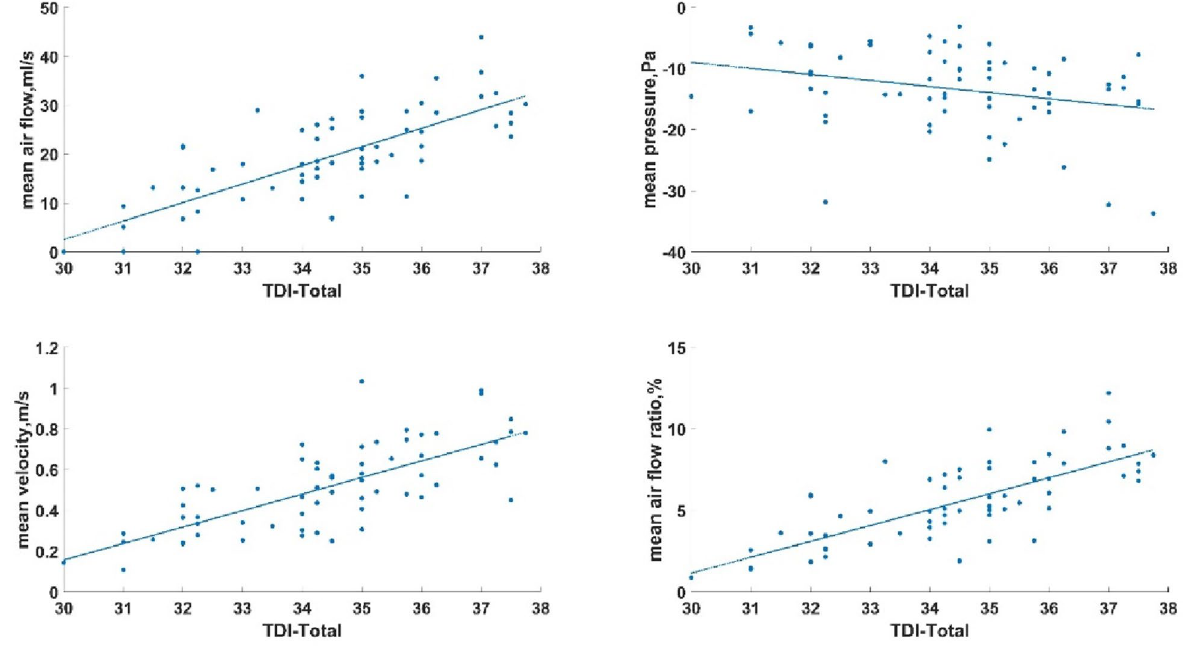
Figure 5. The correlation between airflow parameters and TDI score(created by Matlab R2021a, https:// softw are. sysu. edu. cn/ matla